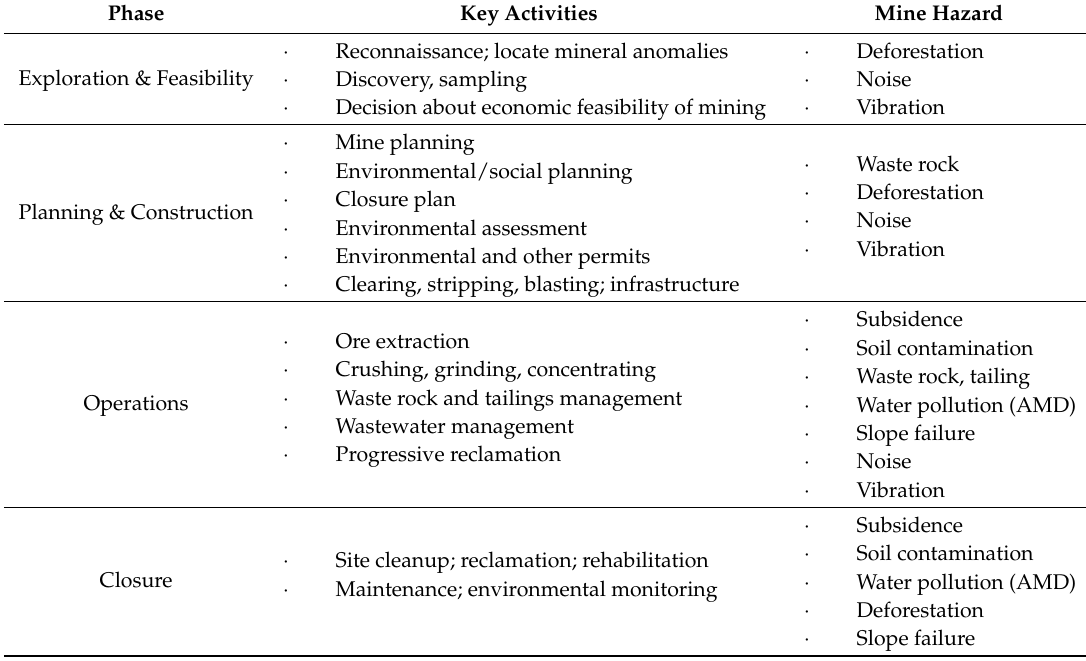
Table 1. Mining-induced hazards according to the mine life cycle (modified from Environment Canada [4]). Phase Key Activities Mine